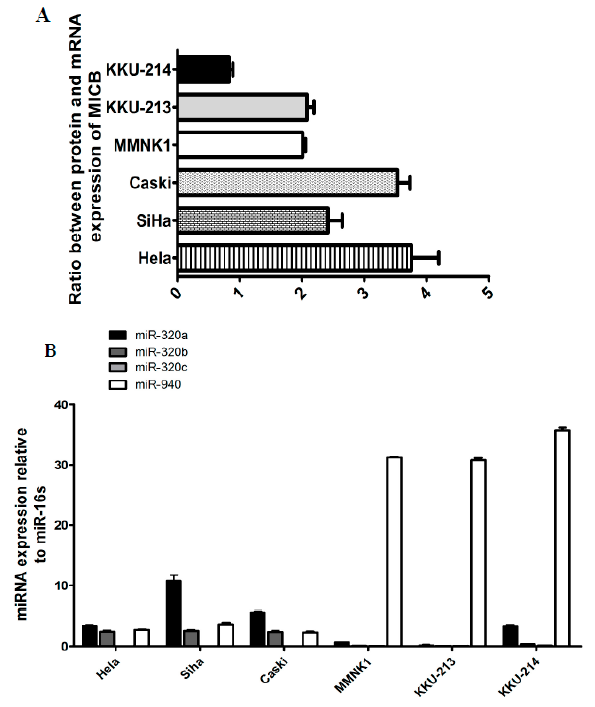
Figure 1 . The endogenous expression of protein and messenger RNA ( mRNA ) of MHC class I chain related protein B ( MICB ) as well as candidate microRNAs ( miRNAs ) in various human cancer cell lines .( A ) The protein expression levels of MICB were divided by mRNA expression levels of MICB to show ratio between protein and mRNA expression; ( B ) Endogenous expression levels of nine candidate miRNAs were measured in human cancer cell lines by quantitative real - time polymerase chain reaction ( qRT - PCR ) ( candidate miRNAs that were not detected are not shown ). The expression levels were normalized to miR - 16 . The results are depicted as mean ± standard error of mean ( S . E . M ). Relative expression was calculated as : 2 Δ Ct , where Δ CT = CT givenmiRNA - CT miR - 16 .